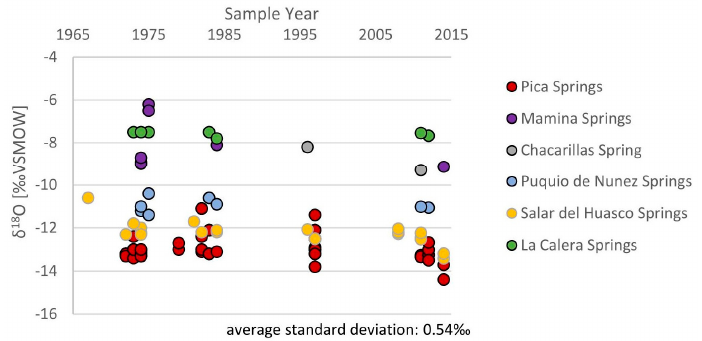
Figure 6. Time series of δ 18 O measurements at different spring sites in the study area and average standard deviation in ‰VSMOW (1967–2014).